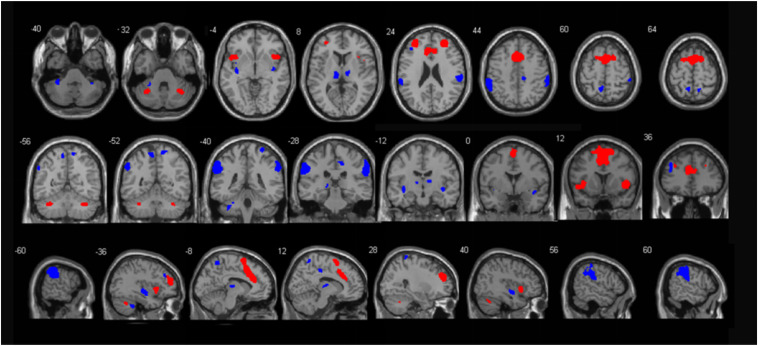
Illustration of the anterior (red) and posterior (blue) SN regions. These templates were created by Shirer and colleagues (http://findlab.stanford.edu/functional_ROIs.html).